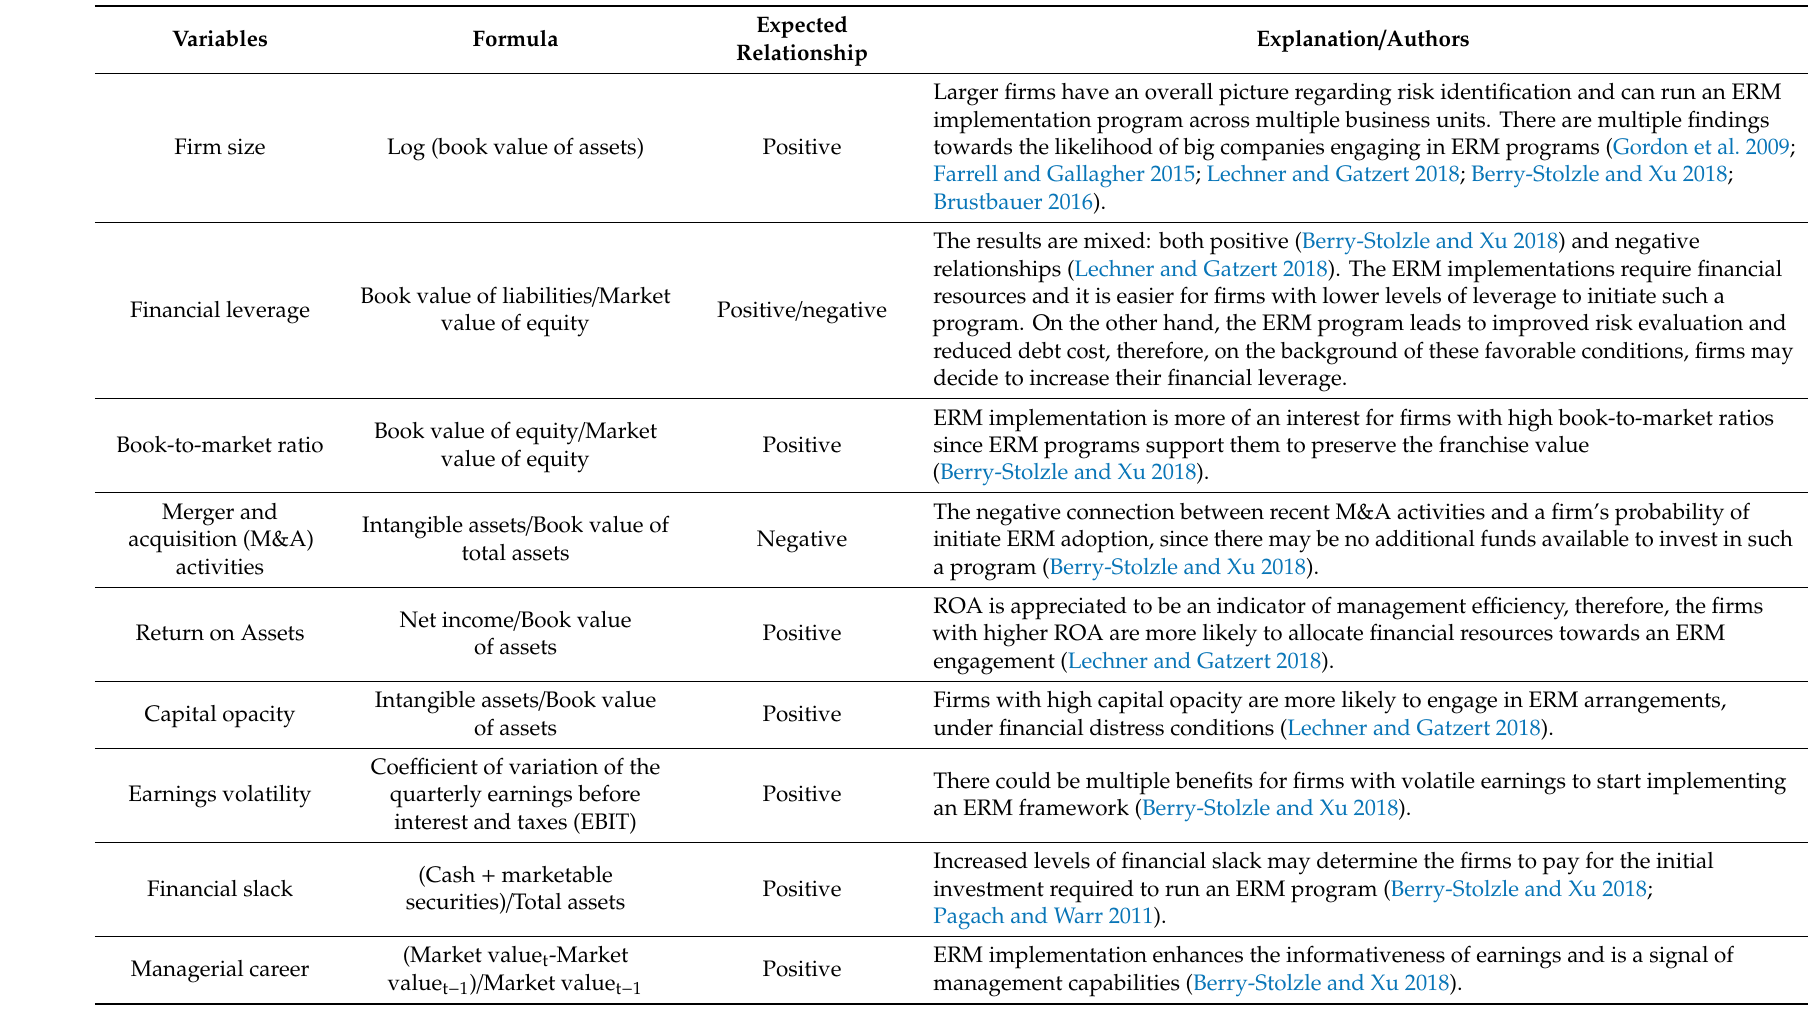
Table 5. The determinants of ERM